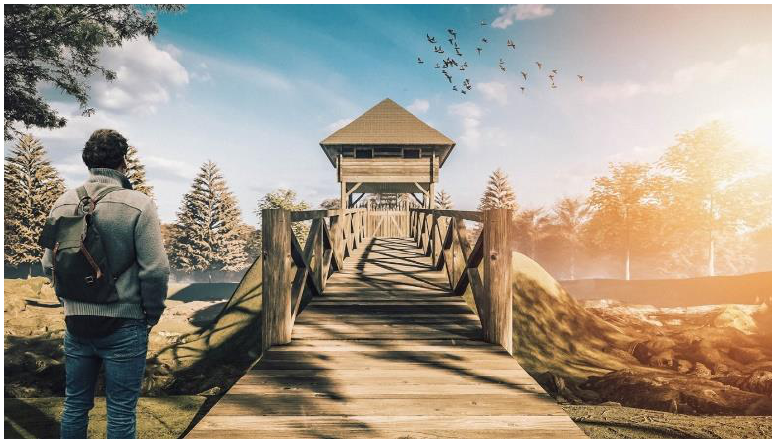
Figure 10. Bridge leading to the watchtower over the trench [70].